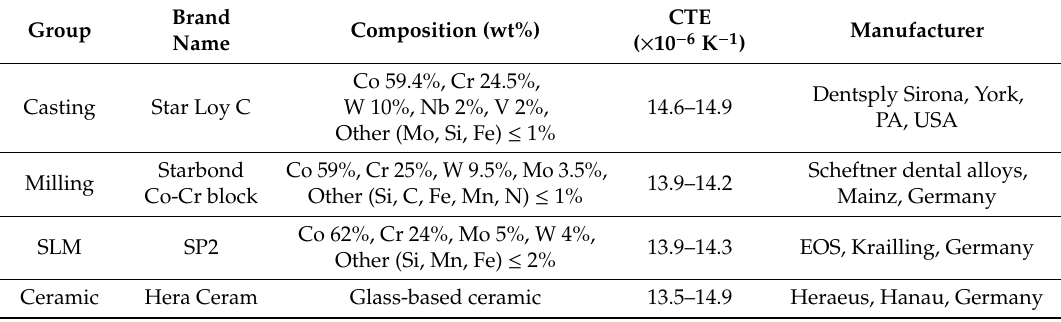
Table 1. Specifications of the materials used in this